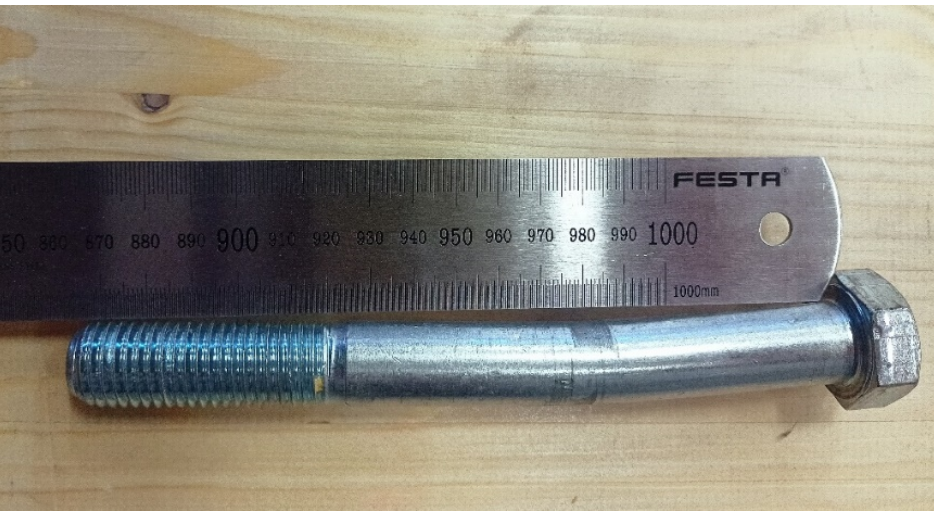
Figure 24. Deformed bolt after the experimental testing.